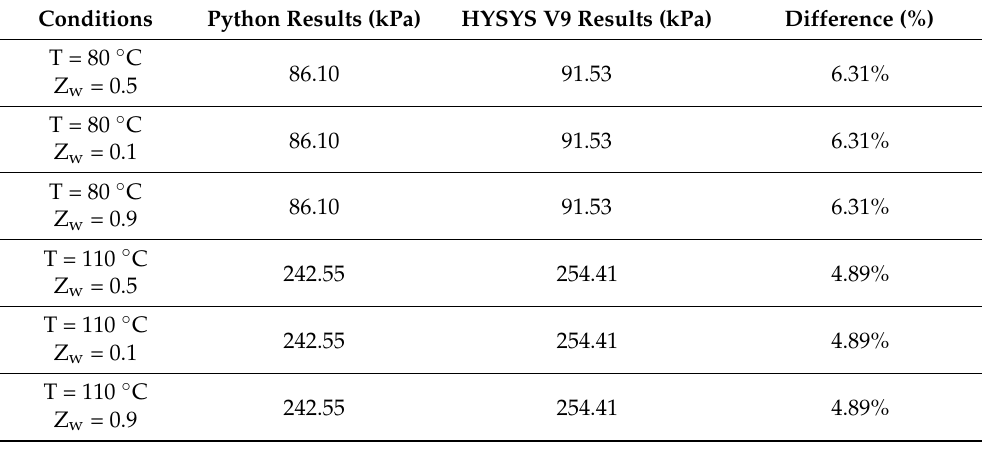
Table 3. Pressure calculation results for water/PASN system in VLLE region (no air).